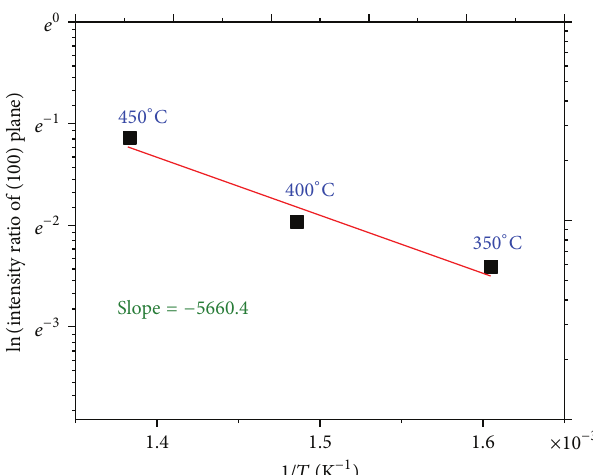
Figure 7: The Arrhenius plot of intensity ratio of (100) crystal plane of the GZO film grown on a thick 422 nm ZnO buffer layer against the reciprocal of the absolute temperature.